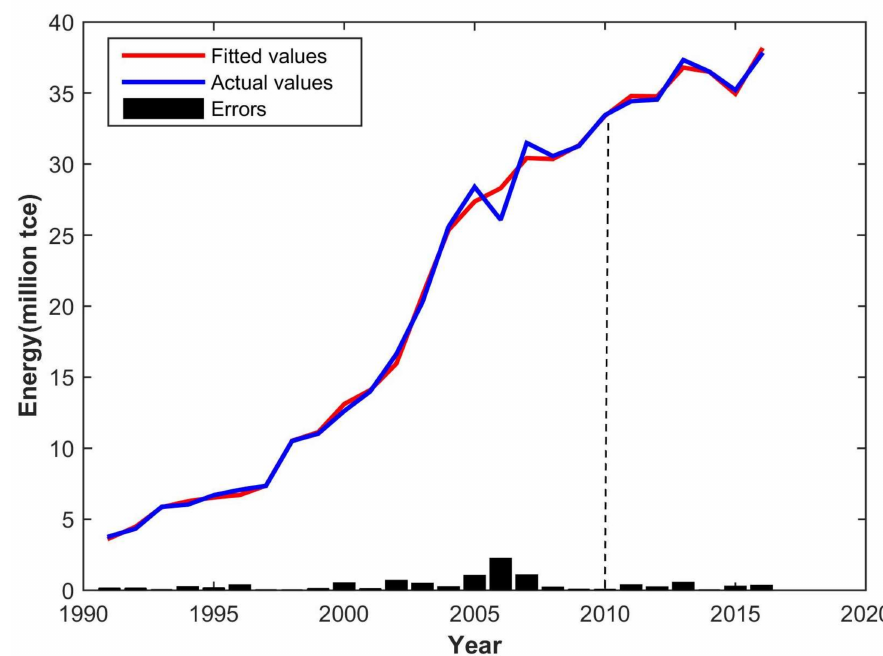
Figure 5. MLR fitting results for water demand.